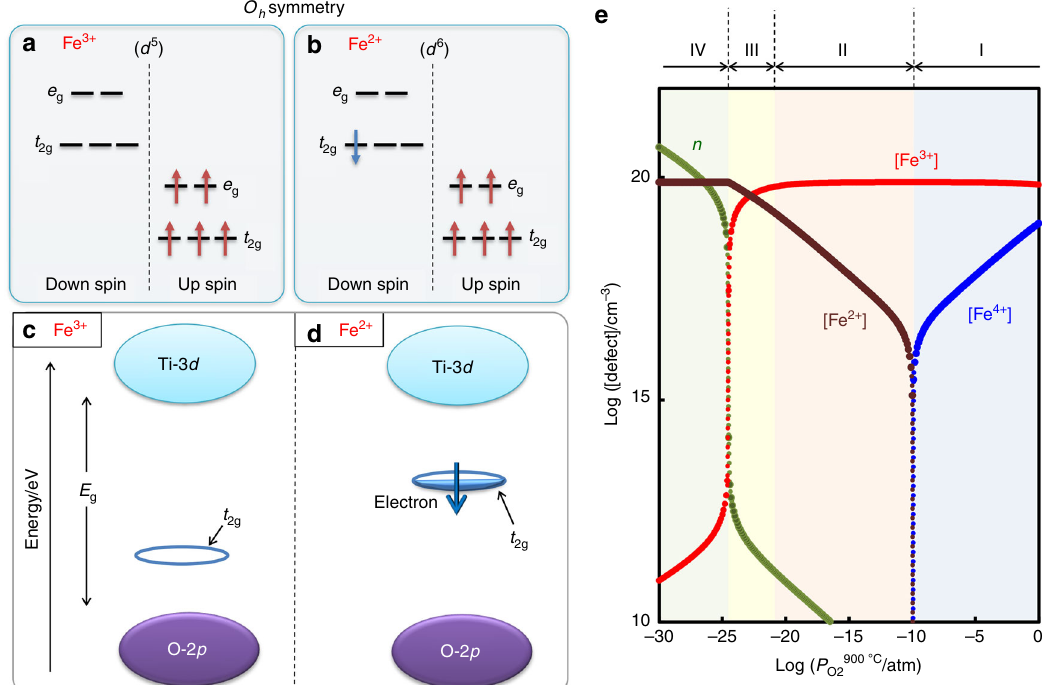
Fig. 1 Defects states in Fe-doped BaTiO 3 . a , b Electronic con fi gurations in the high-spin state of Fe 3 + and Fe 2 + in O h symmetry. c , d Gap states derived from Fe 2 + and Fe 3 + in the bandgap ( E g ) between the conduction band (Ti-3 d ) and the valence band (O-2 p ) in the host BaTiO 3 lattice. e Defect concentrations at 25 °C as a function of oxygen partial pressure ( P o 2 900°C ) at 900 °C (annealing temperature). In the region III, Fe 2 + and Fe 3 + coexist and their defect (gap) states can be utilized as scaffolds for visible-light absorption. In the Fe 2 + -Fe 3 + coexisting state, photoinduced carriers are expected to be generated as follows: the unoccupied t 2g state of Fe 3 + c is positioned above the valence band maximum (VBM, the top of the O-2 p band) and then play the role of an electron acceptor, while the electron-occupying t 2g state of Fe 2 + d is located below the conduction band minimum (CBM, the bottom of the Ti-3 d band) and then acts as an electron